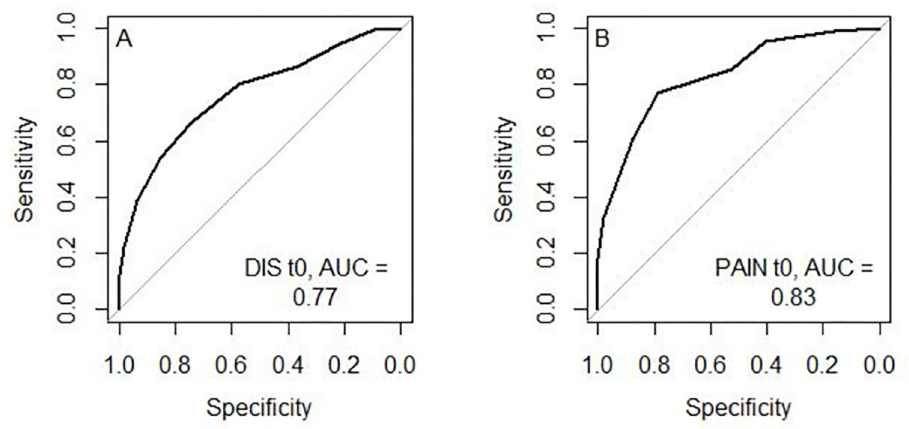
Fig 2. Receiver operating characteristic curves disability and pain at inclusion (t0). Combined disability score (DIS) and pain versus STarT-MSK G .